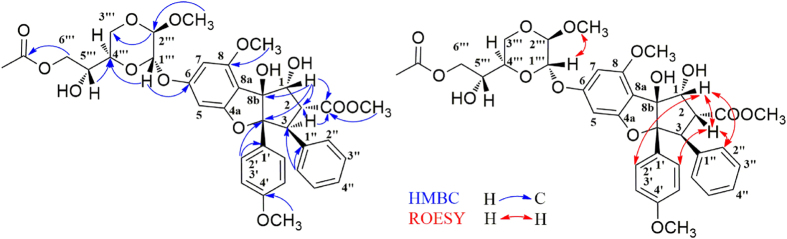
Selected key HMBC and ROESY correlations observed for 1.